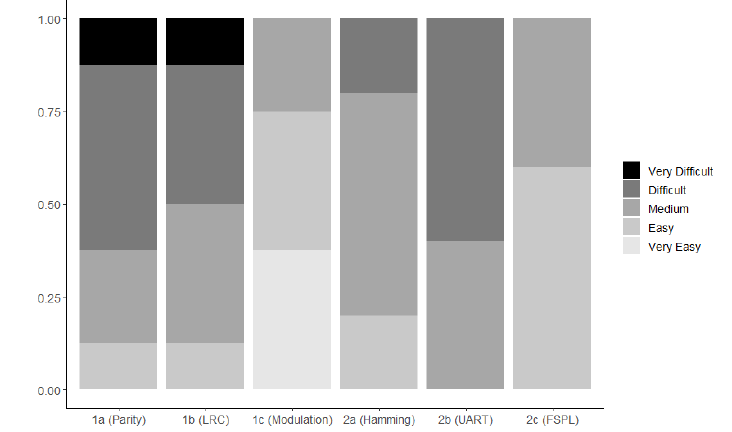
Figure 4. Survey results rating puzzle difficulty.